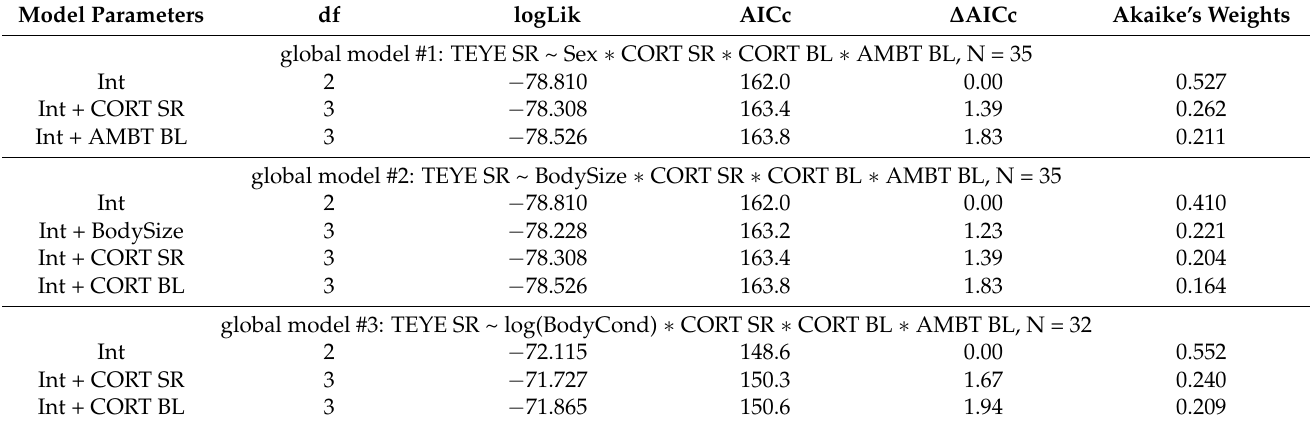
Table 3. Rank of the highest-ranked linear models within global models estimating the effects of various predictors on thermal (TEYE SR) or hormonal (CORT SR) stress response. Codes: AMBT BL—baseline ambient air temperature, BodySize—total head length, BodyCond—scaled mass index, Int—intercept, and CORT BL—corticosterone baseline level. Only the best models with ∆ AICc ≤ 2 are presented; Akaike’s weights were calculated from the full set of models. df – degrees of free- dom, logLik—log-likelihood, AICc—Second-order Akaike Information Criterion, ∆ AICc—difference between the best model (with smallest AICc) and each model.